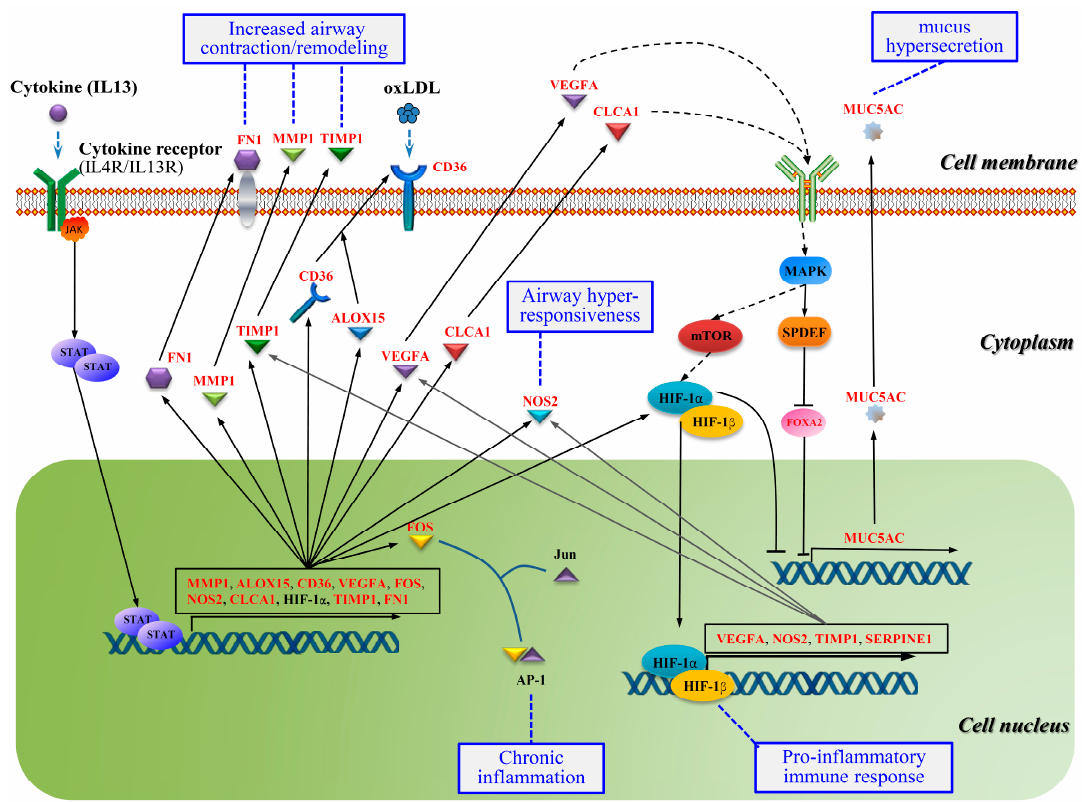
Figure 7. Cross-talking pathways associated with asthma inferred by DEGs as well as literature.